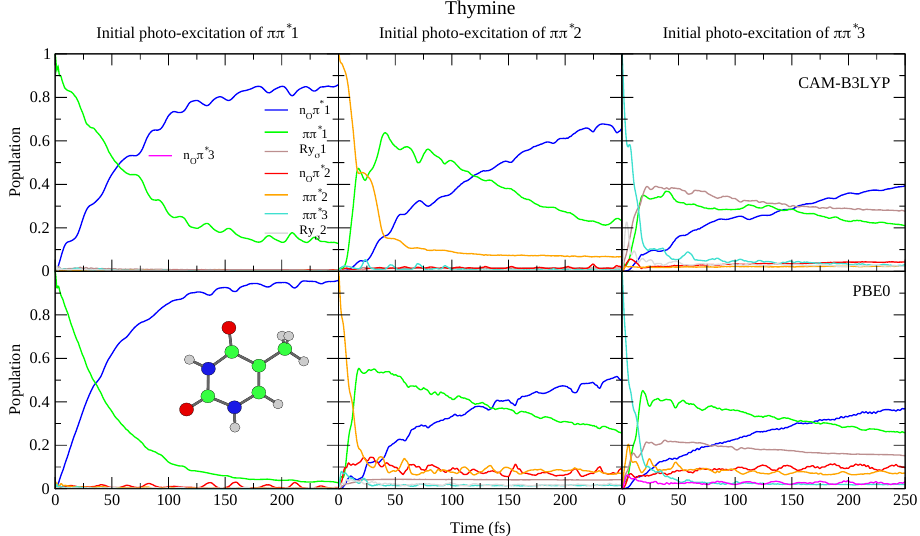
Figure 5. Nonadiabatic dynamics of electronic populations of Thymine in the gas phase, as predicted by an LVC Hamiltonian parameterised with calculations at the FC point using CAM-B3LYP ( top ) and PBE0 ( bottom ) functionals with 6-311+G(d,p) basis